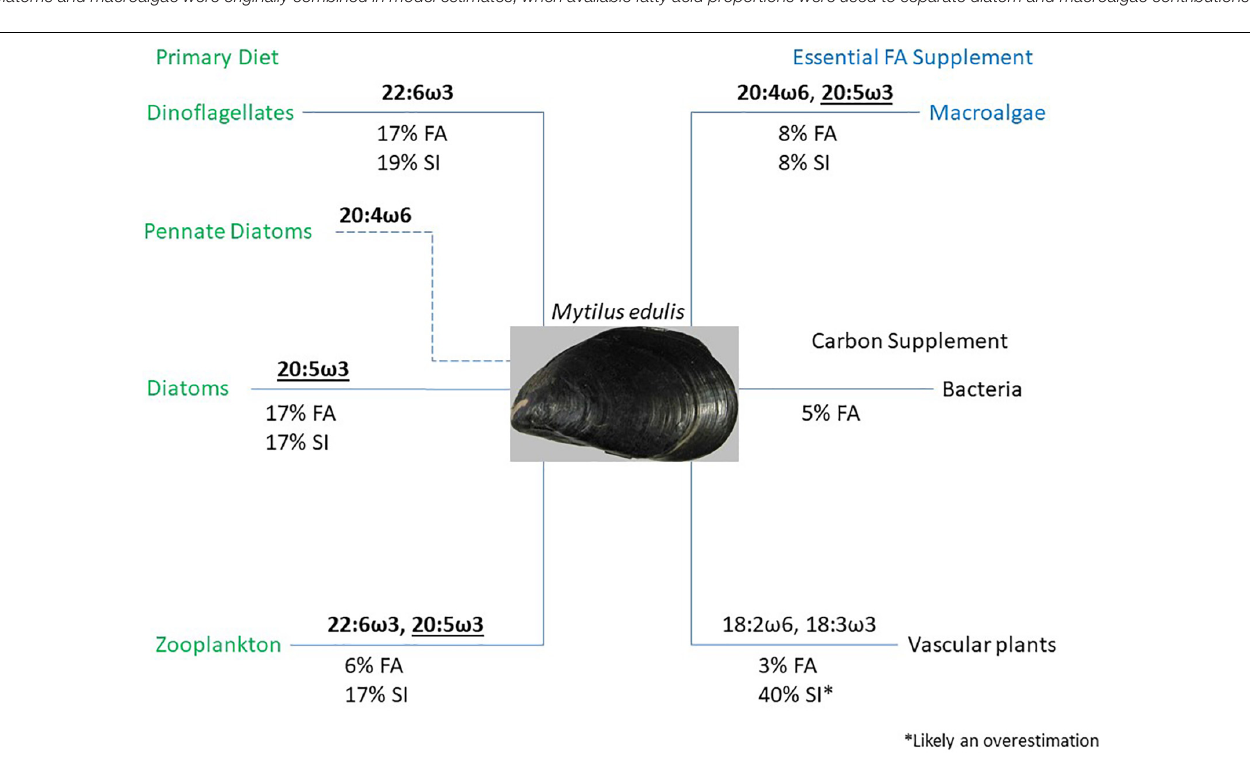
contributions of live vs. dead phytoplankton to their diets. By assuming all phytoplankton ingested are fresh our estimates of detrital usage are inherently conservative and underestimate